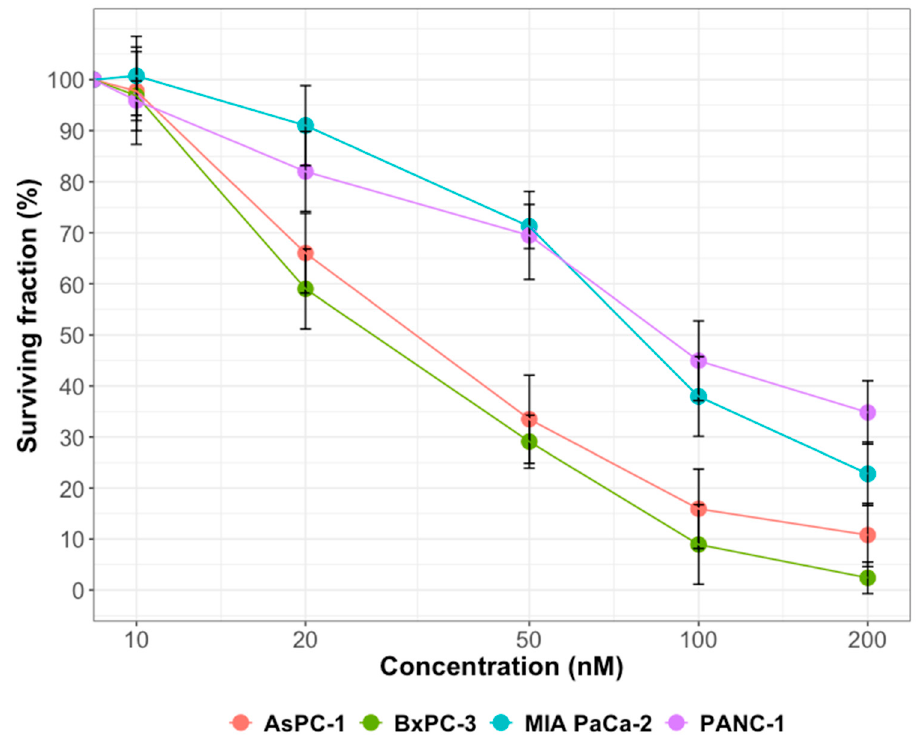
Figure 1. Cell survival of PDAC cell lines, AsPC-1, BxPC-3, MIA PaCa-2 and PANC-1, after gemcitabine treatments. Cells were treated with 10 to 200 nM gemcitabine for 24 h and cell survival was determined using clonogenic assay. Experiments were done in triplicate and represent mean with standard error. Table 1. Surviving fraction calculated after treatment with olaparib (1 µM) or gemcitabine (10 nM) for AsPC-1, BxPC-3, MIA PaCa-2 and PANC-1 cell lines.